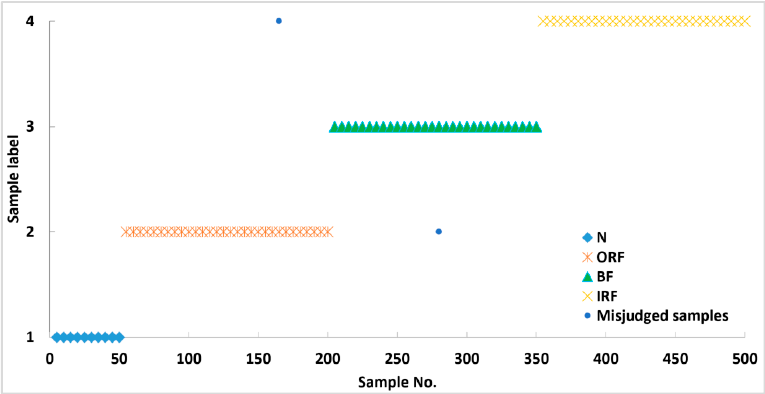
Figure 14. Classification result of the proposed method for bearing dataset.